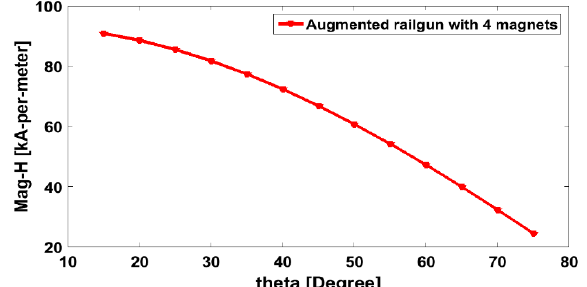
Figure 7: Magnetic field intensity of permanent magnet structure with four magnets versus oblique angles .